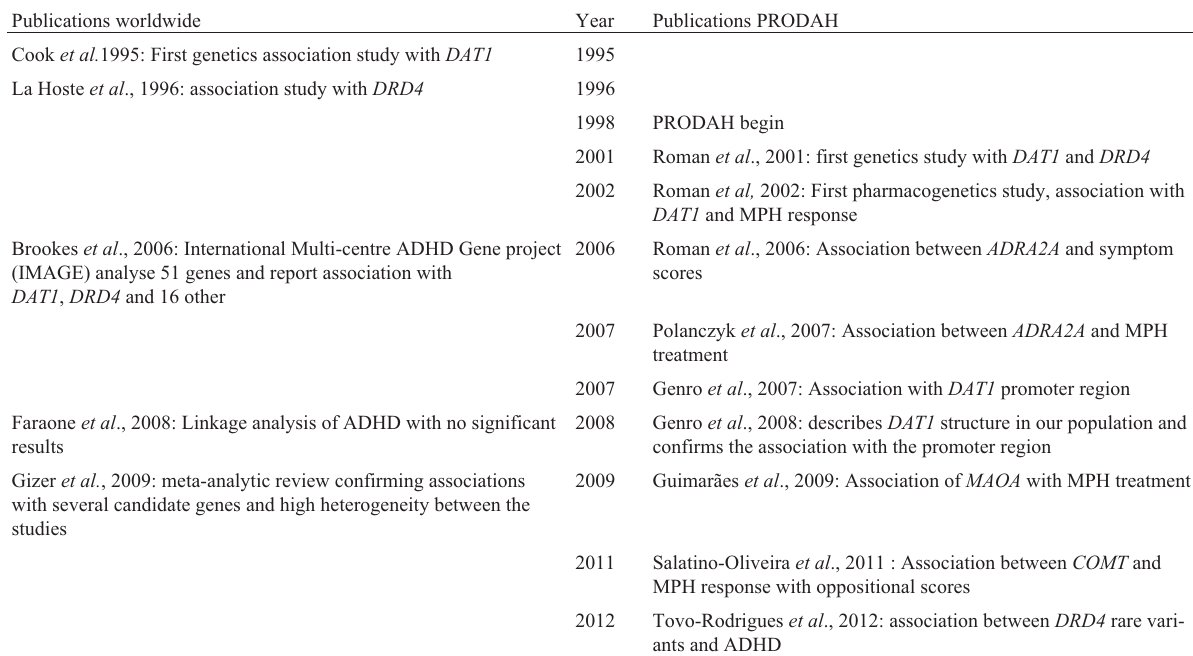
Table 3 - Timeline of international literature’s and our group’s most relevant